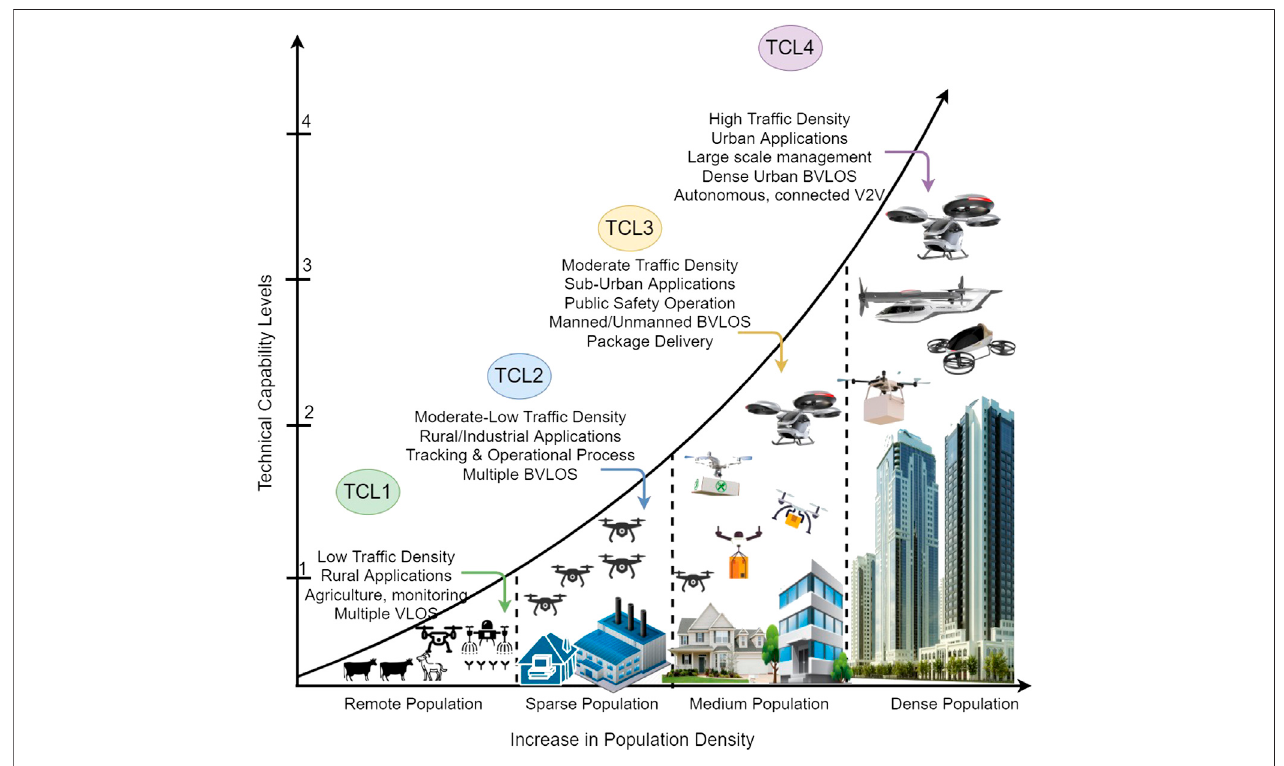
FIGURE 4 | UTM ’ s Technical Capability Levels